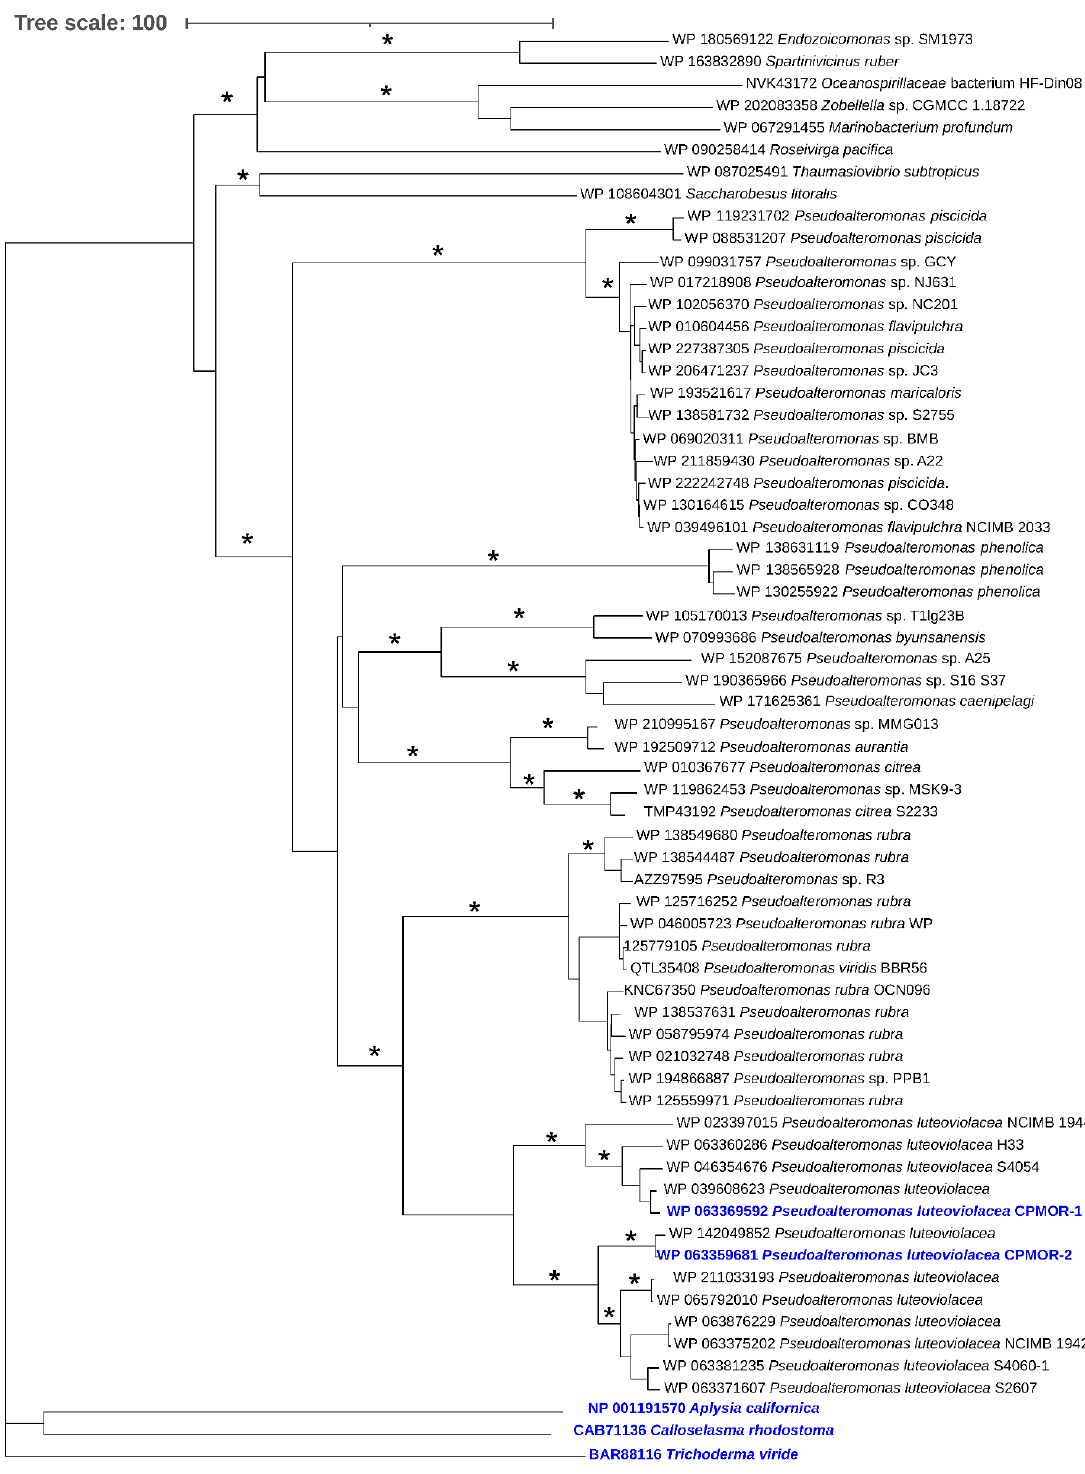
Figure 9. Phylogenetic relationship of proteins with similarity to PlLAAO. The tree shown was constructed using the neighbor-joining method integrated in the program MEGA X [32]. The tree is drawn to scale, with branch lengths in the same units as those of the evolutionary distances used to infer the phylogenetic tree. Asterisk at the branches indicate bootstrap values higher than 90% for the phylogenetic analyses performed with both the neighbor-joining and maximum likelihood methods. Colored blue are the P. luteoviolacea strains CPMOR-1 and CPMOR-2 and the proteins from the non-bacterial species.